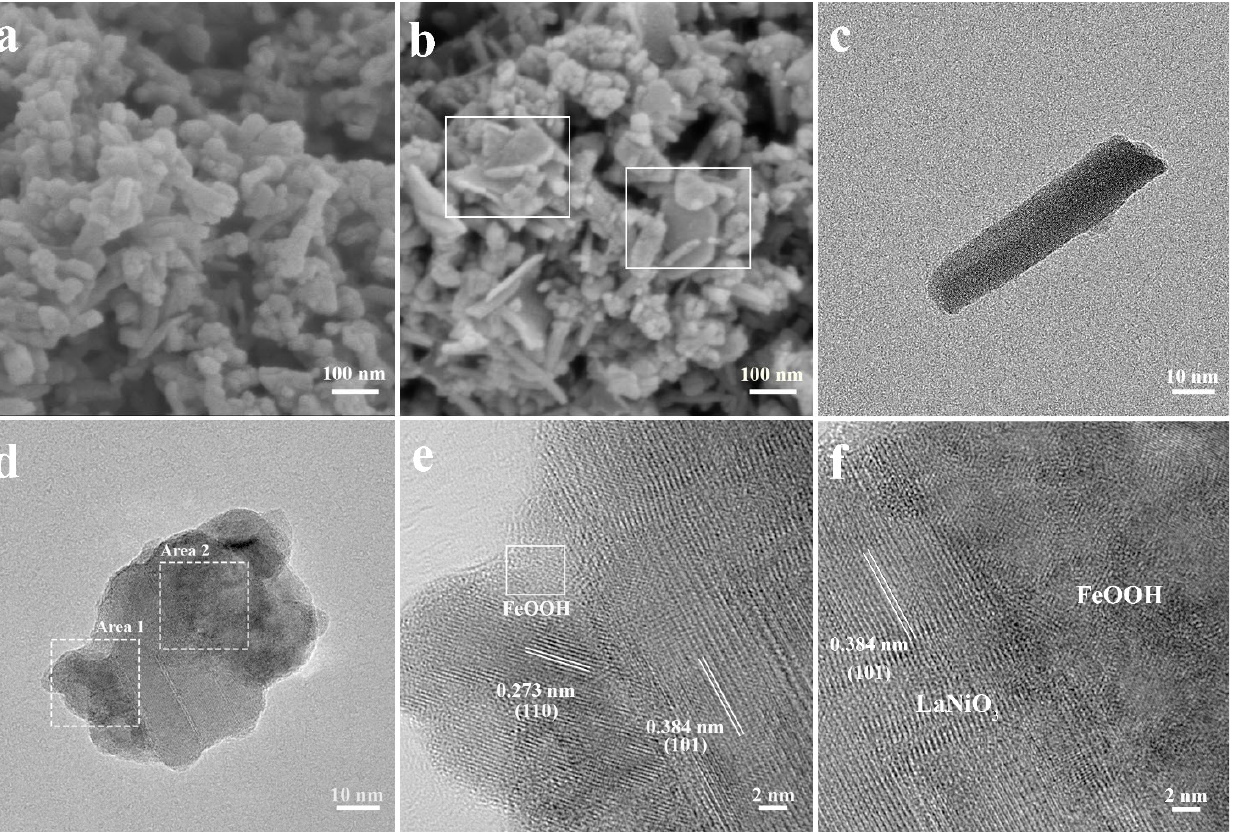
Figure 2. SEM images of ( a ) LNO and ( b ) 0.25Fe ‐ LNO. TEM images of ( c ) LNO and ( d ) 0.25Fe ‐ LNO. HRTEM image of 0.25Fe ‐ LNO corresponding to the ( e ) Area 1 and ( f ) Area 2, as marked in ( d ).